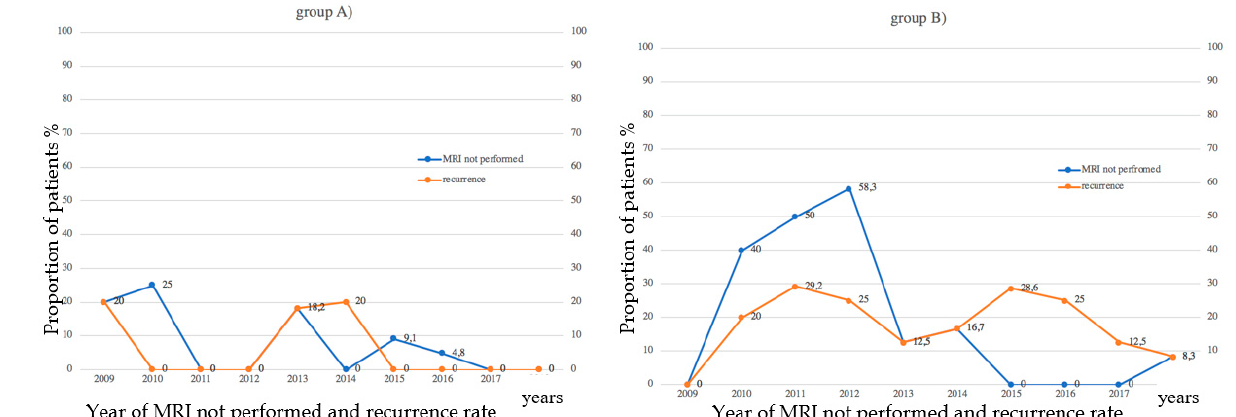
Figure 2. Proportional relationship between pre-surgical MRI assessments and the recurrence rate. A higher recurrence rate per year was observed in both groups when pre-operative MRI assessments were not performed.